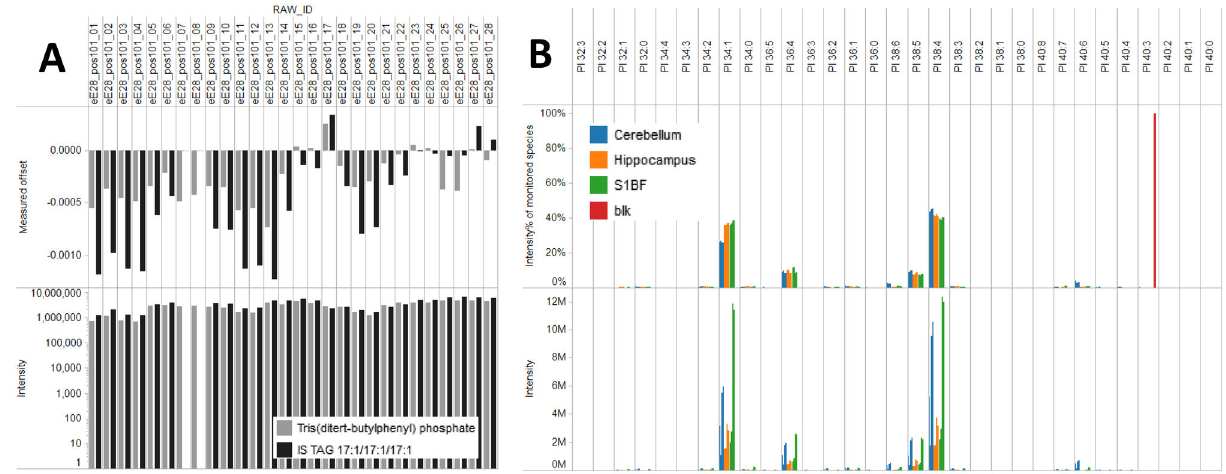
Figure 4. Quality control analysis. ( A ) Monitoring of lock mass offset and lock mass ion intensity as function of sample injection. Notice that the lock mass and internal standard TAG 17:1/17:1/17:1 is not detected in injection 07 and 08. Manual inspection of FT MS spectra revealed that the particular sample had not been spiked with internal standards. ( B ) Assessing the specificity of the PI species profile and intensity across all samples from wild-type mice and the negative control blank samples. Note that in the negative control blank sample (red) a low abundant background ion is detected and falsely identified as PI 40:3. Dubious lipid species can be removed using background subtraction and filtering during subsequent processing in Orange. doi: